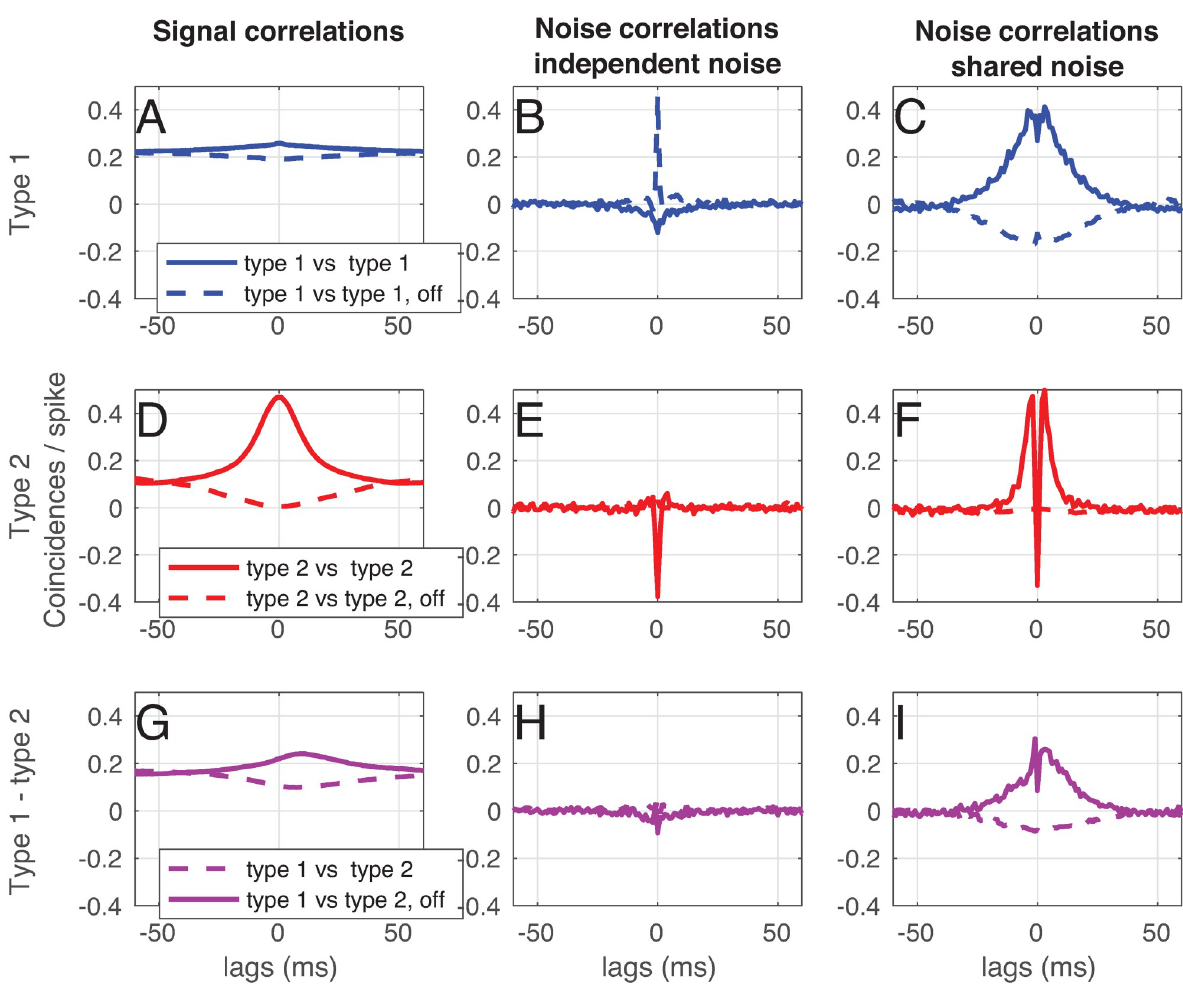
Fig 6. Signal and noise correlations in a network with ‘type 1’ and ‘type 2’ neurons. (see section Analysis and Fig 3). Next to the stimulus, each neuron in the network was presented with a noise input (of which half the power was independent, and half was shared with a subset of other neurons). A) Signal correlations between ‘type 1’ on-cells (solid blue line) and between a ‘type 1’ on and off cell (dashed blue line). B) Noise correlations between ‘type 1’ on-cells (solid blue line) and between a ‘type 1’ on and off cell (dashed blue line) receiving independent noise. C) Noise correlations between ‘type 1’ on-cells (solid blue line) and between a ‘type 1’ on and off cell (dashed blue line) receiving shared noise. D) Signal correlations between ‘type 2’ on-cells (solid red line) and between a ‘type 2’ on and off cell (dashed red line). E) Noise correlations between ‘type 2’ on-cells (solid blue line) and between a ‘type 2’ on and off cell (dashed red line) receiving independent noise. F) Noise correlations between ‘type 2’ on-cells (solid red line) and between a ‘type 2’ on and off cell (dashed red line) receiving shared noise. D) Signal correlations between a ‘type 1’ and a ‘type 2’ on-cell (solid purple line) and between a ‘type 1’ on and a ‘type 2’ off cell (dashed purple line). E) Noise correlations between a ‘type 1’ on-cell and a ‘type 2’ on-cell (solid purple line) and between a ‘type 1’ on and a ‘type 2’ off cell (dashed purple line) receiving independent noise. F) Noise correlations between a ‘type 1’ on-cell and a ‘type 2’ on-cell (solid purple line) and between a ‘type 1’ on and a ‘type 2’ off cell (dashed purple line) receiving shared noise. Network parameters: Δ = 7, 5 ms, ν = μ = 1, 5, N = 100, N trial = 300. Stimulus: τ = 15 ms, amplitude = 2.7. Noise: τ = 15 ms, amplitude independent noise = 0.5, amplitude shared noise =